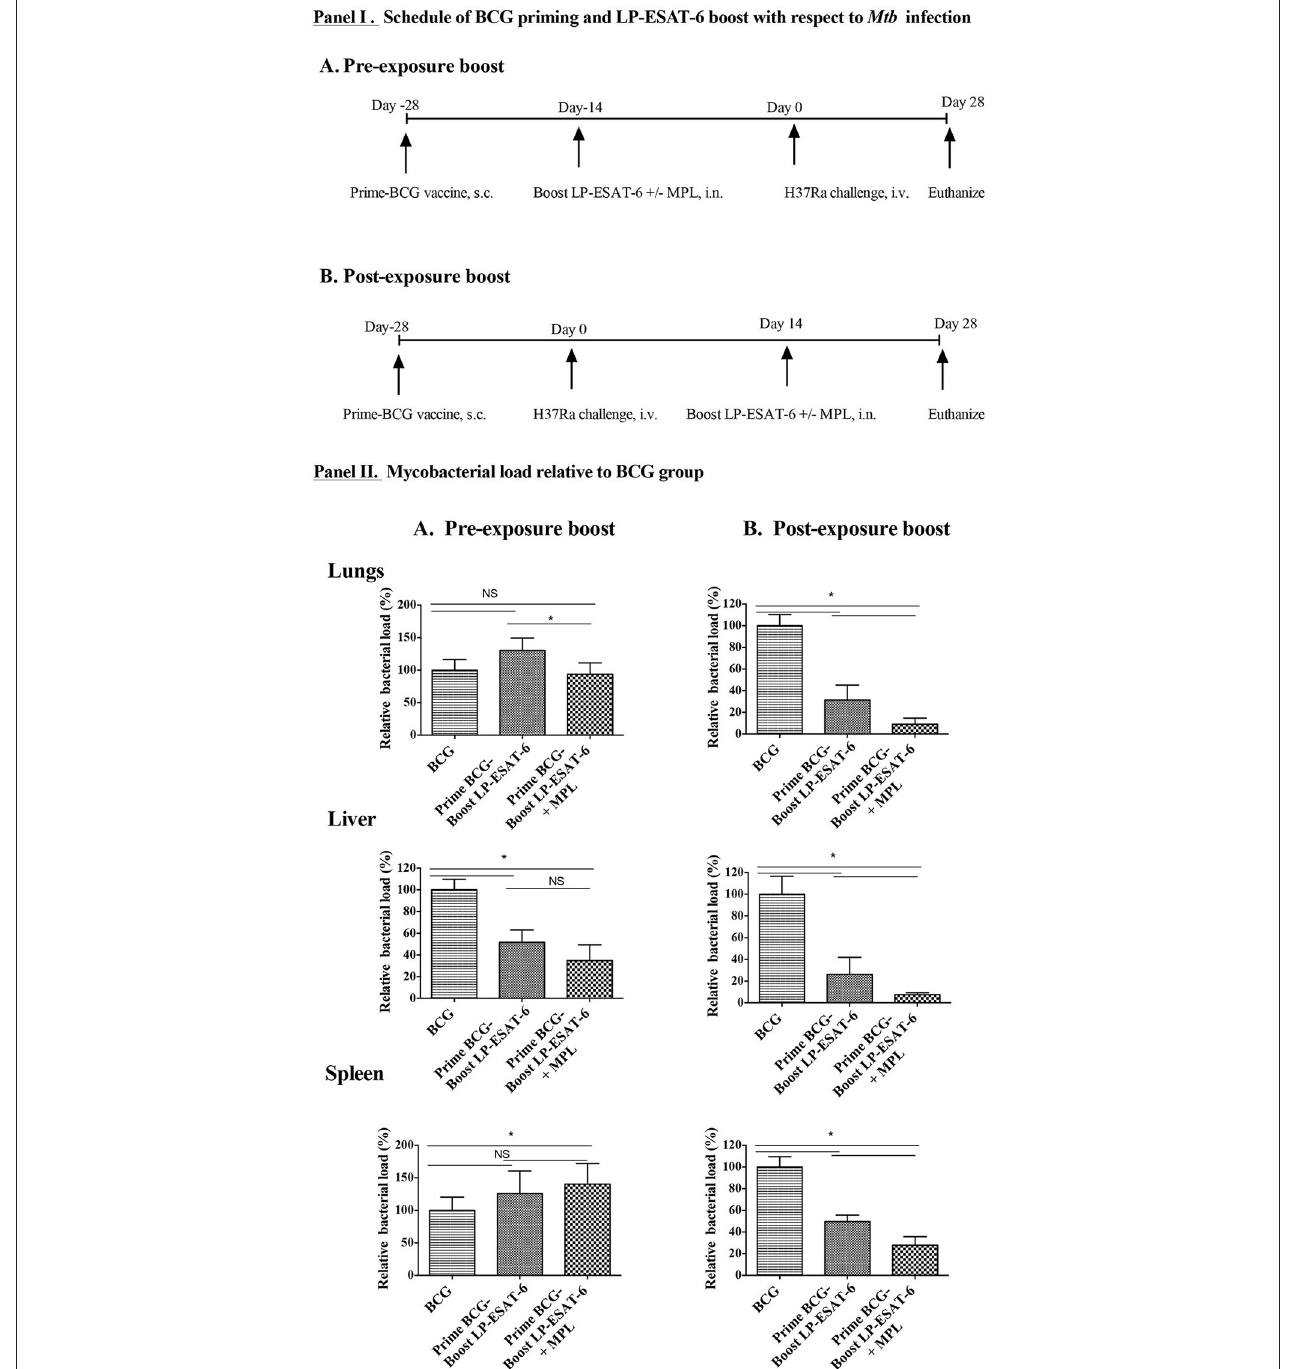
FIGURE 1 | Decrease in Mtb loads is dependent on schedule of the boost in heterologous prime-boost with BCG/LP-ESAT-6. (I) . Experimental design of BCG priming (s.c.) and LP-ESAT-6 boost (i.n.) using pre- and post-exposure schedules. (II) . Female BALB/c mice ( n = 5/group) were immunized subcutaneously with BCG (1 x 10 6 live BCG, 100 µ l/mouse) or PBS (unvaccinated group). A mixture of P1 and P4-P7 lipopeptides (12 µ g each) alone and combined with MPL was administered intranasally as LP-ESAT-6 boost according to the schedule shown in (I) , either before or after infection with H37Ra (0.5 × 10 6 cfu) intravenously. Four weeks after Mtb -challenge, mice were euthanized and lungs, liver and spleens were collected from all groups. Bacterial loads were determined in lungs, liver and spleen by CFU assay. Mycobacterial reduction in (A) pre-exposure boost and (B) post-exposure boost of immunization is presented as percent relative bacterial load with respect to the corresponding BCG-alone group. All results are shown as mean ± standard deviation of percent relative bacterial load from individual mice. Data are representative of two different repeated experiments. *Indicates significant difference ( P < 0.05) between the compared groups and “NS” represents not significant ( P > 0.05).